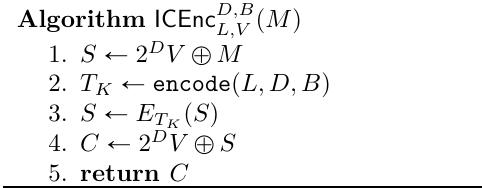
Figure 1: Definition of ICEnc , the core encryption routine of ICE . ICEnc is common to all three variants of ICE , ICE1 and ICE2 and ICE3 except the definition of encode . Note that ICE1 and ICE3 fix V “ 0 n , hence effectively S Ð M (line 1) and C Ð S (line 4). Variables L and V are assumed to be derived from the corresponding KDF taking p N, K q , as a pre-processing. KDFs are defined in Section